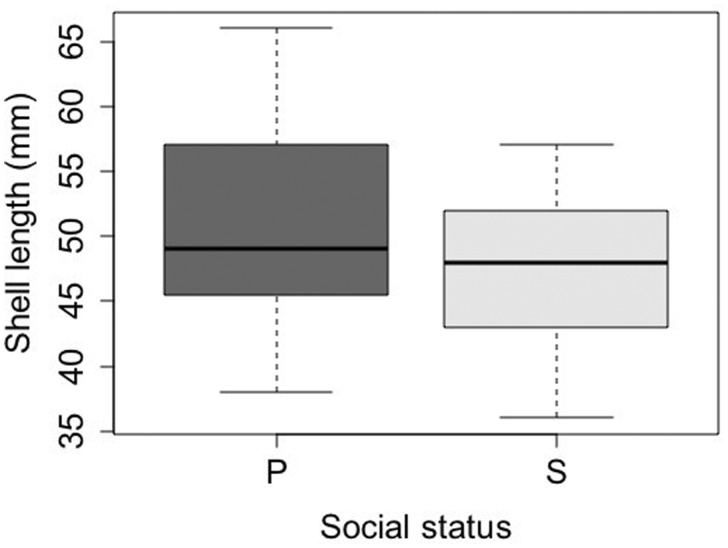
Shell length of paired (n = 21) and solitary (n = 56) S. gigas from which behavior and egg mass data were collected. The box plot shows the median shell length (dark horizontal line), first and third quartiles (box), and minimum and maximum shell length (whiskers) for paired (P) and solitary (S) limpets, respectively.